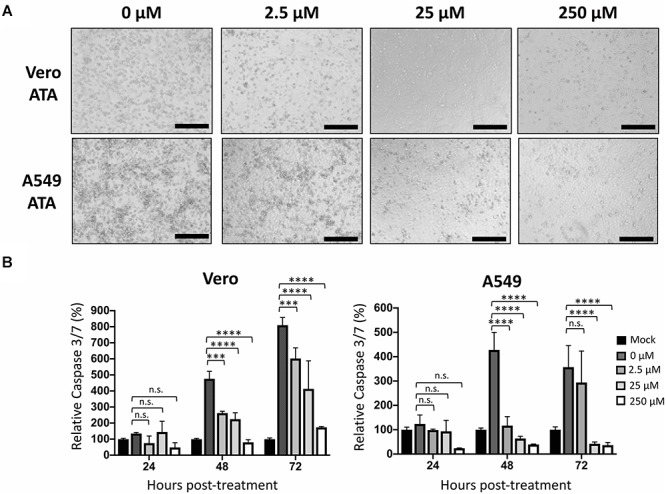
Aurintricarboxylic acid protects Vero and A549 cells from ZIKV-induced cell death: Vero and A549 cells (24-well plate format, 2.5 × 105 cells/well, triplicates) were infected (MOI 0.1) with Paraiba/2015. After 1 h viral adsorption, cells were treated with the indicated concentrations (250, 25, 2.5, and 0 μM) of ATA. At 48 h p.i., cells were observed and imaged under an optical microscope. Scale bar = 100 μm. (A) Caspase 3/7 levels were measured in the tissue culture supernatants at 24, 48, and 72 h p.i. (B) Data of each time point was compared to mock-infected control cells and expressed as mean of relative percentage and SD from three independent experiments conducted in triplicates. Statistical analyses were conducted by two-way ANOVA, ∗p < 0.0332, ∗∗p < 0.0021, ∗∗∗p < 0.0002, ∗∗∗∗p < 0.0001, or no significance (n.s.).